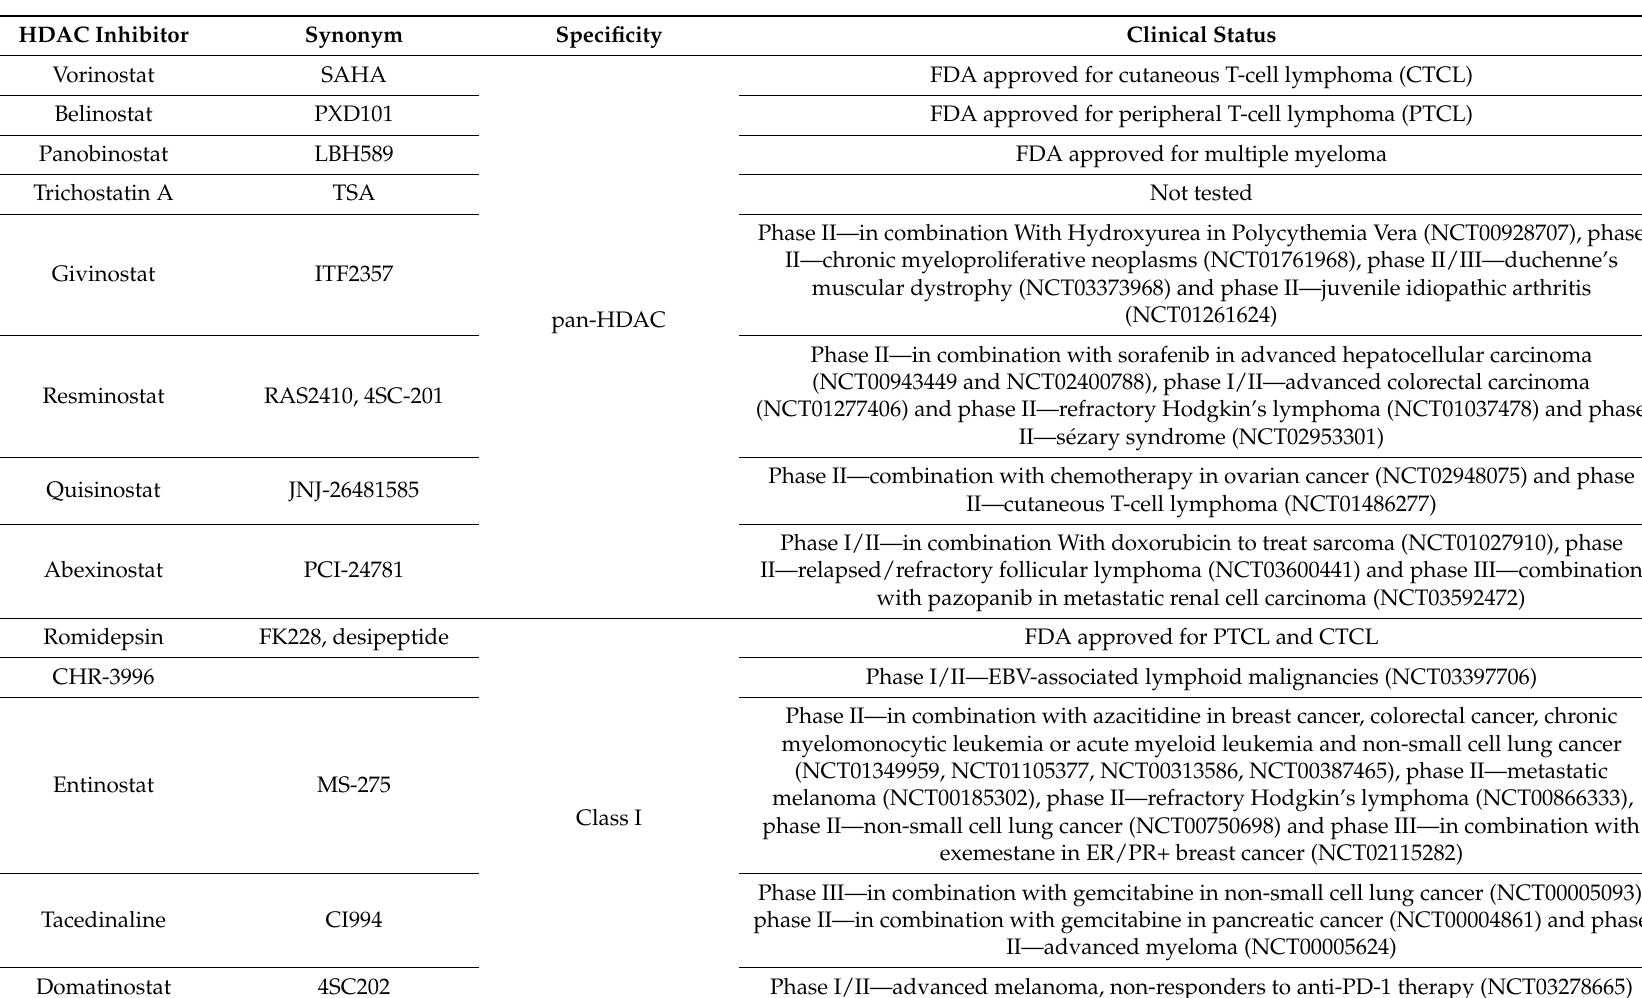
Table 1. HDAC inhibitors clinical status. The clinical trials information was obtained from https://clinicaltrials.gov/, accessed on: 31 January